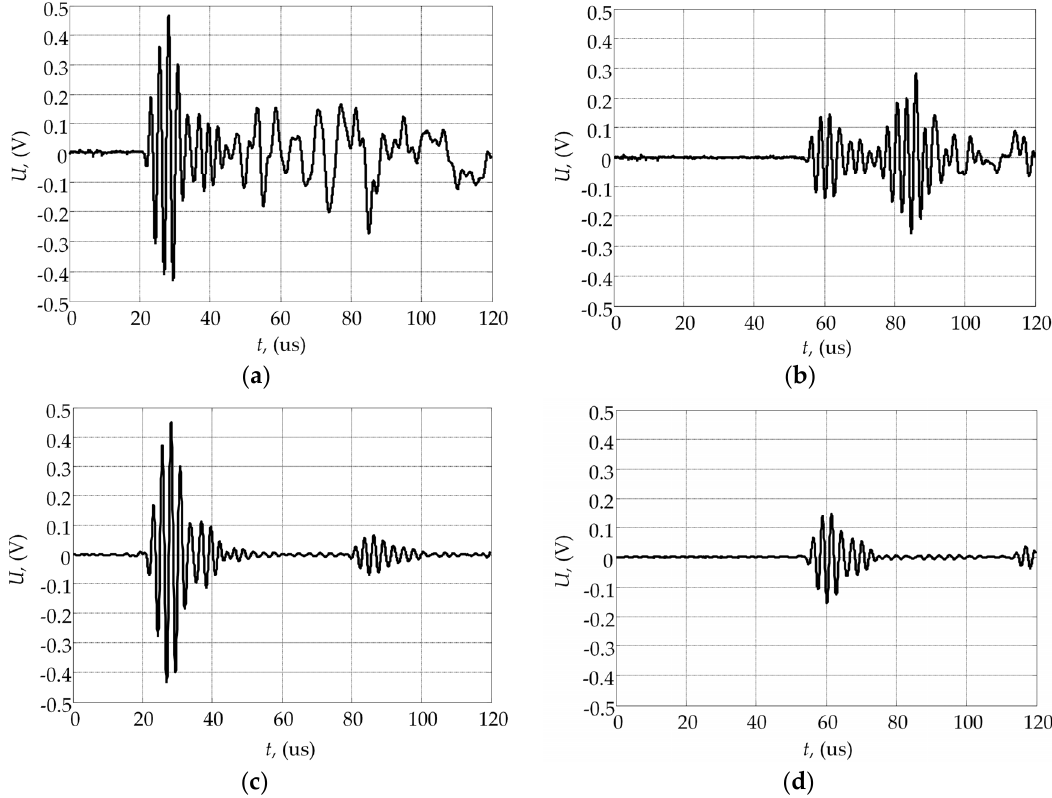
Figure 13. Waveforms of the ultrasonic guided wave signals measured: ( a ) before lap joint weld; ( b ) after lap joint weld; ( c ) waveform of the signal before the lap joint weld after applying spatial mode filtering; ( d ) waveform of the signal after the lap joint weld after applying spatial mode filtering.